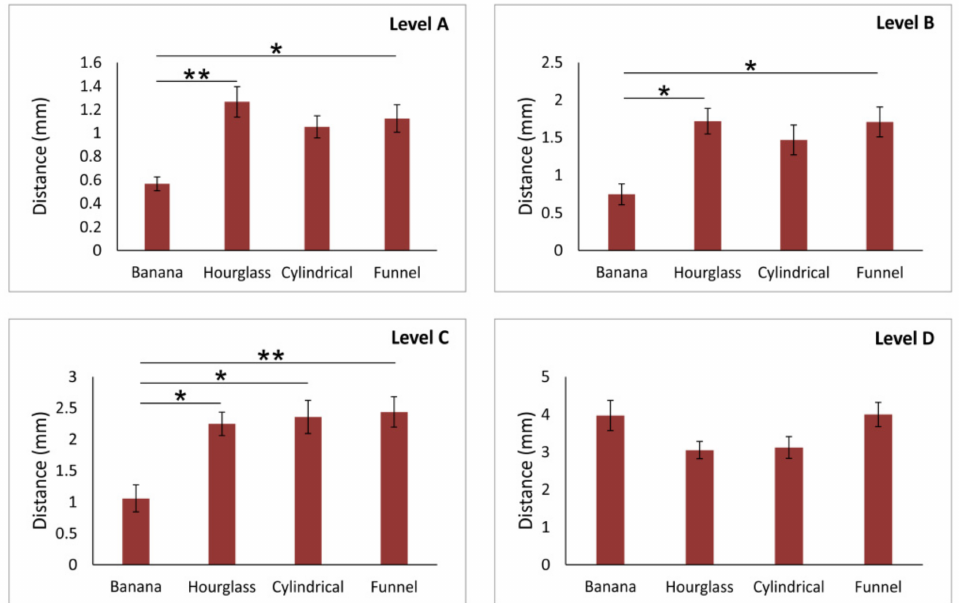
Figure 4. The distance of accessory canal from NPC at different levels of anterior maxilla according to NPC shape. Values are expressed as the mean ± SEM. * denotes a significant difference of p < 0.05, ** denotes a significant difference of p <